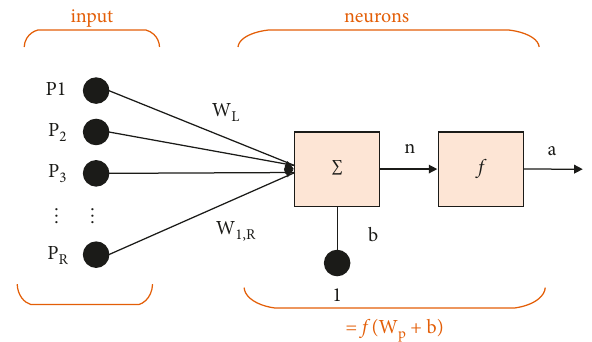
Figure 2: Neuron model of BP network.